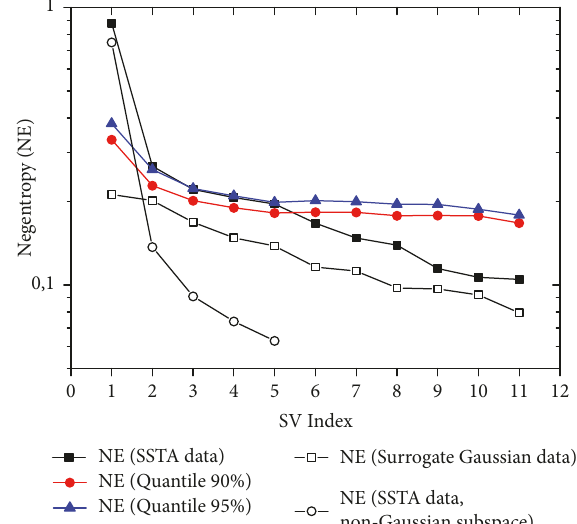
̃ M ( z ) , 𝑘 = 1,...,𝑁 = 11 , contributing to Figure 6: Ranked SVs 𝑘𝑘 NE, both from real SSTA data (solid squares) and from Gaussian surrogate realizations (open squares) and 90% (red), 95% (blue) [̃ M ( b )] obtained from Gaussian surrogates after quantiles of 𝑄 𝑝 𝑘𝑘 𝑘 sig ̃ M ( z ) . The trailing 6 SVs is not rank 𝑘 , to be compared with 𝑘𝑘 = 95 %, leading to 𝑁 = 5 . The NE components significant at 𝑝 sig ng-Ed restricted to the non-Gaussian subspace are marked as open